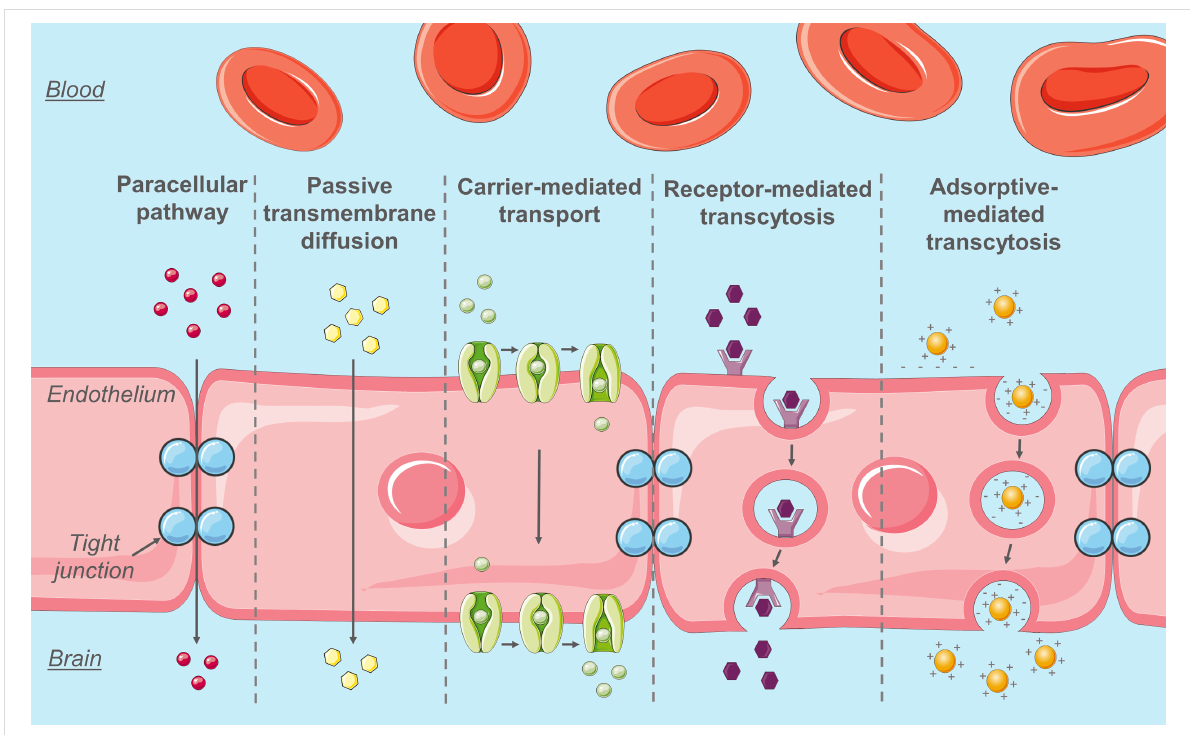
Figure 3: Physiological pathways through the BBB. Inspired by [3]. Made using cliparts from Servier Medical Art by Servier, https://smart.servier.com/. Original cliparts are licensed under a Creative Commons Attribution 3.0 Unported License, https://creativecommons.org/licenses/by/3.0/.